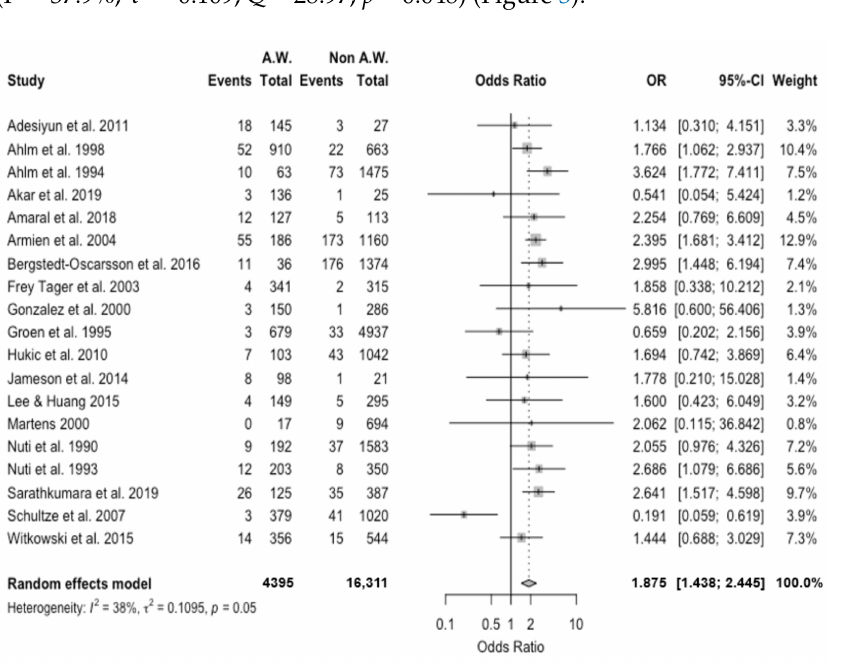
Figure 3. Forest plot representing the association of positive status for hantavirus serology (i.e., “Event”) in Agricultural Workers (AW) compared to the reference population (Non AW). In summary, seropositivity for Hantavirus was associated with the occupational status as AW with an odds ratio (OR) equal to 1.875, 95% confidence interval (95% CI)